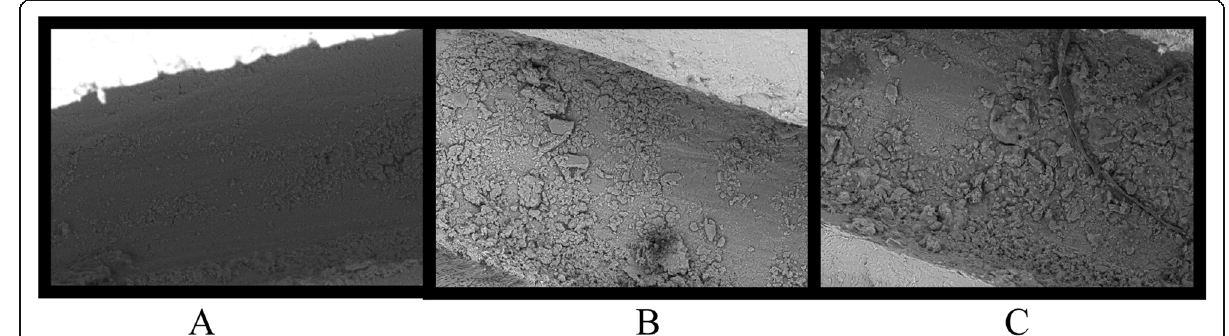
Fig. 7 SEM images of group 2. a Coronal. b Middle. c